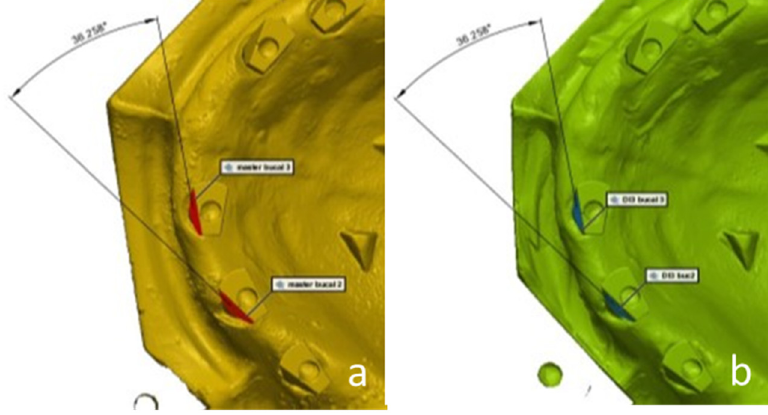
Figure 7. A digital measurement of the angle between the buccal surface of each scan abutment to the same surface on the adjacent scan abutment. a —master model scan; b —study group scan